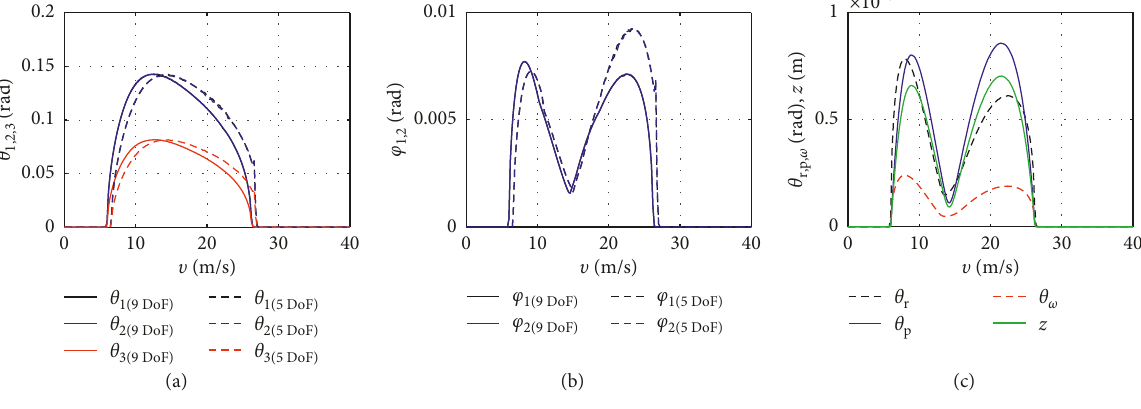
1,2,3 . (b) The amplitudes of φ 1,2 .